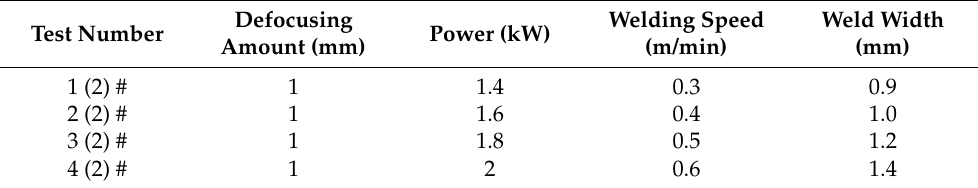
and four-level orthogonal test.